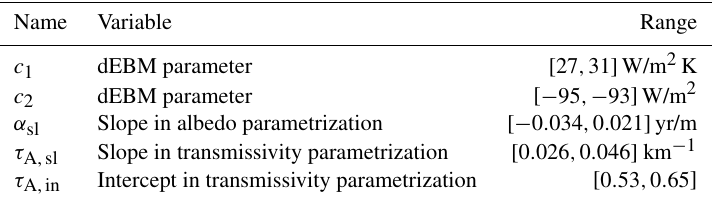
Table E1. Overview of the experiments performed in this